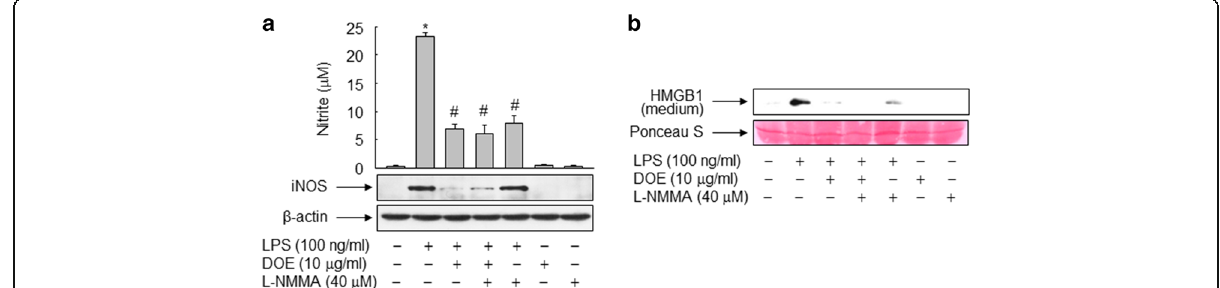
Fig. 5 DOE inhibits LPS-triggered release of HMGB1 through inhibition of NO formation in RAW 264.7 cells. a and b Cells cultured for 24 h in serum-free medium were pretreated with or without L-NMMA and then stimulated with vehicle (DMSO) or LPS in the presence or absence of DOE. After incubation for 24 h, aliquots of whole-cell lysates or conditioned media were subjected to immunoblot or nitrite analysis, respectively (s). The levels of HMGB1 were analyzed by immunoblot using equal volumes of conditioned media ( b ). Ponceau S staining and β -actin were used as the loading controls. The blots are representative of three independent experiments. The results are plotted as the means ± S.E. ( n = 6). * , p < 0.01 vs untreated group; # , p < 0.01 vs LPS-treated group